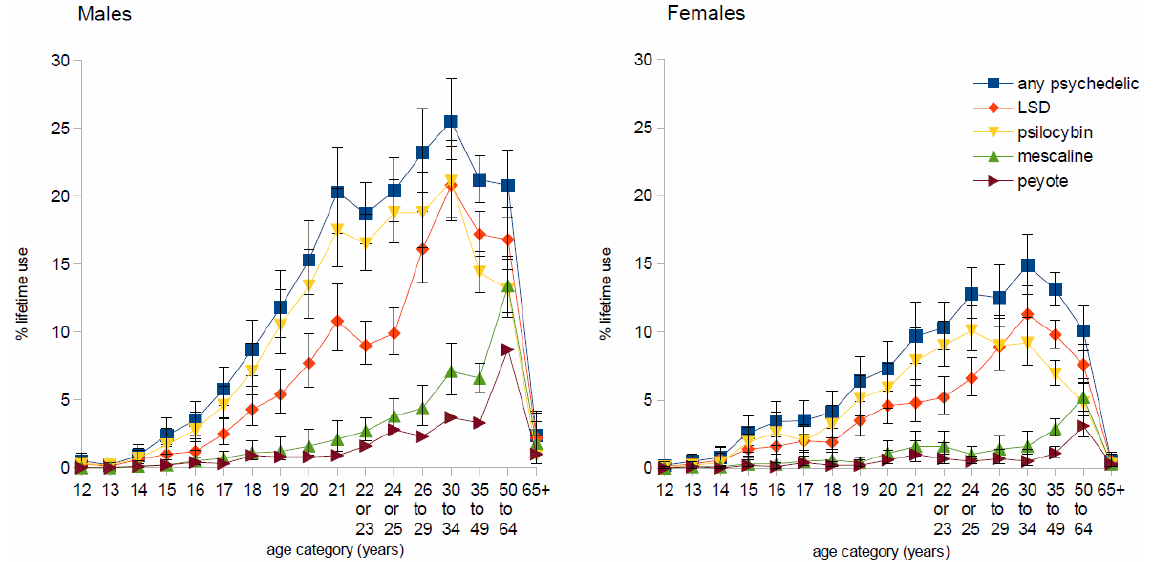
Figure 1. Lifetime psychedelic use by age and gender in the US in 2010. Error bars show 95% confidence intervals. Any psychedelic includes LSD, psilocybin, mescaline, and/or peyote. Mescaline includes both mescaline and peyote. 14-year longitudinal study reported good consistency over time in the reporting of lifetime LSD use 5